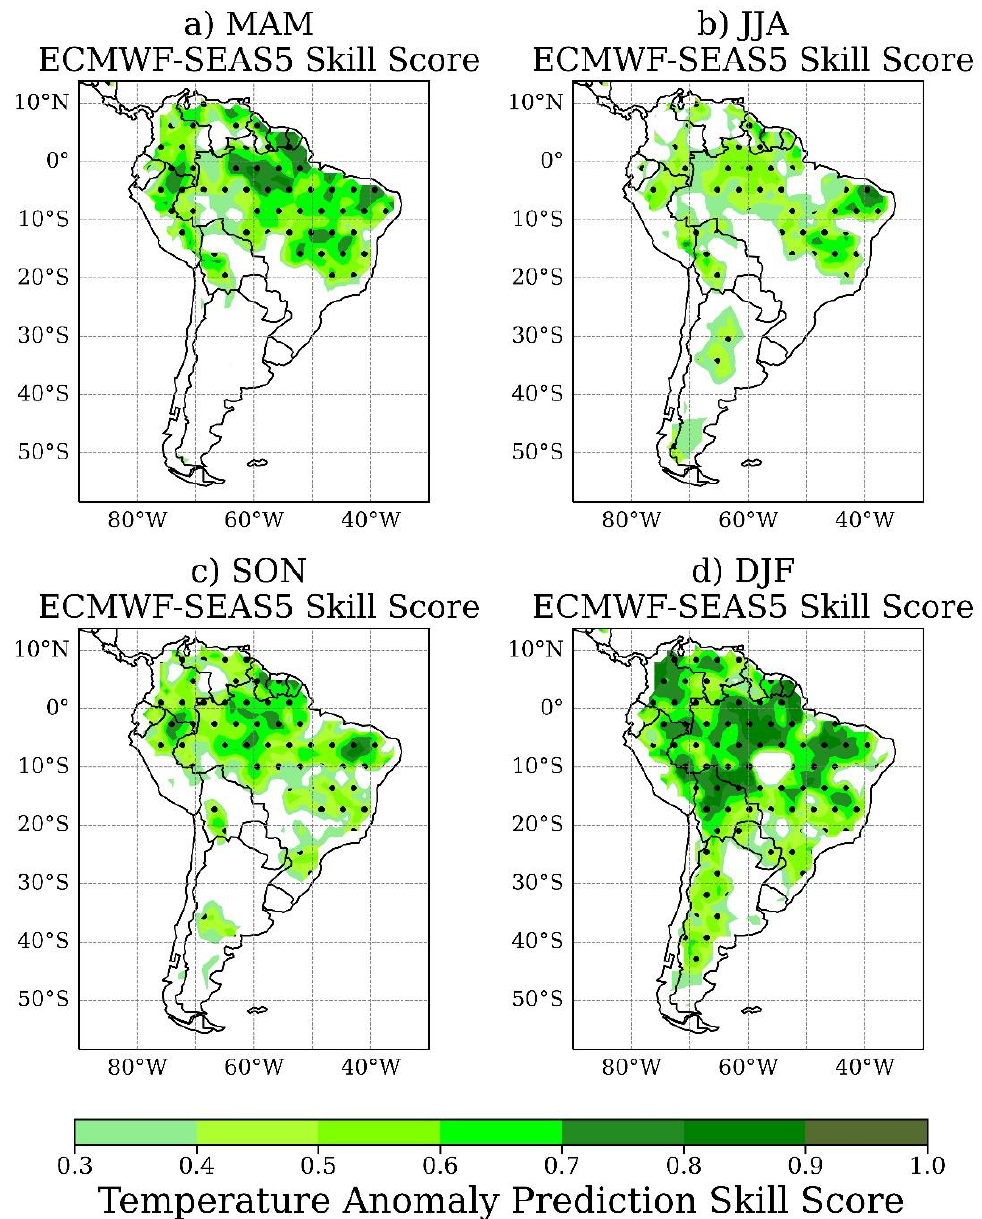
Figure 3. Seasonal 2-m temperature anomaly prediction skill scores greater than 0.3 for the ECMWF- SEAS5 hindcasts for ( a ) MAM, ( b ) JJA, ( c ) SON, and ( d ) DJF. Seasons correspond to reforecasts from the 1 – 3-month lead times. The score is nondimensional. Dotted areas denote statistical significance at a 95% confidence level using the Student’s t -test.